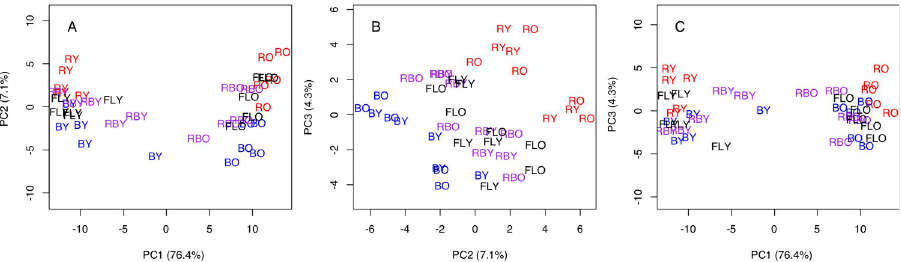
Fig 2. Scatter plots of the PCA scores derived from the leaf transcriptome in the plants grown under the red (R), blue (B), and red/blue (RB) LEDs and the fluorescent (FL) light source conditions. The leaf samples were harvested from young (Y) and old (O) leaves of each of five individual plants grown under the different light sources. The relationships between PC1 and PC2 (A), between PC2 and PC3 (B), and between PC1 and the PC3 (C) are presented with the respective variance